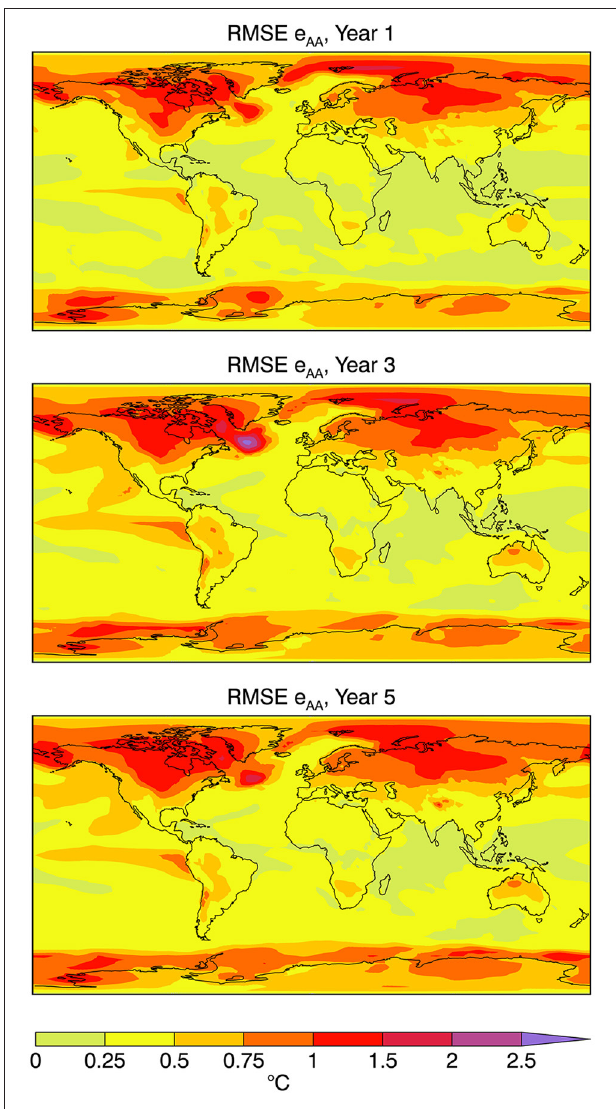
FIGURE 11 | Root mean square error e AA between the ensemble mean analysis X A and the ensemble mean forecast Y A